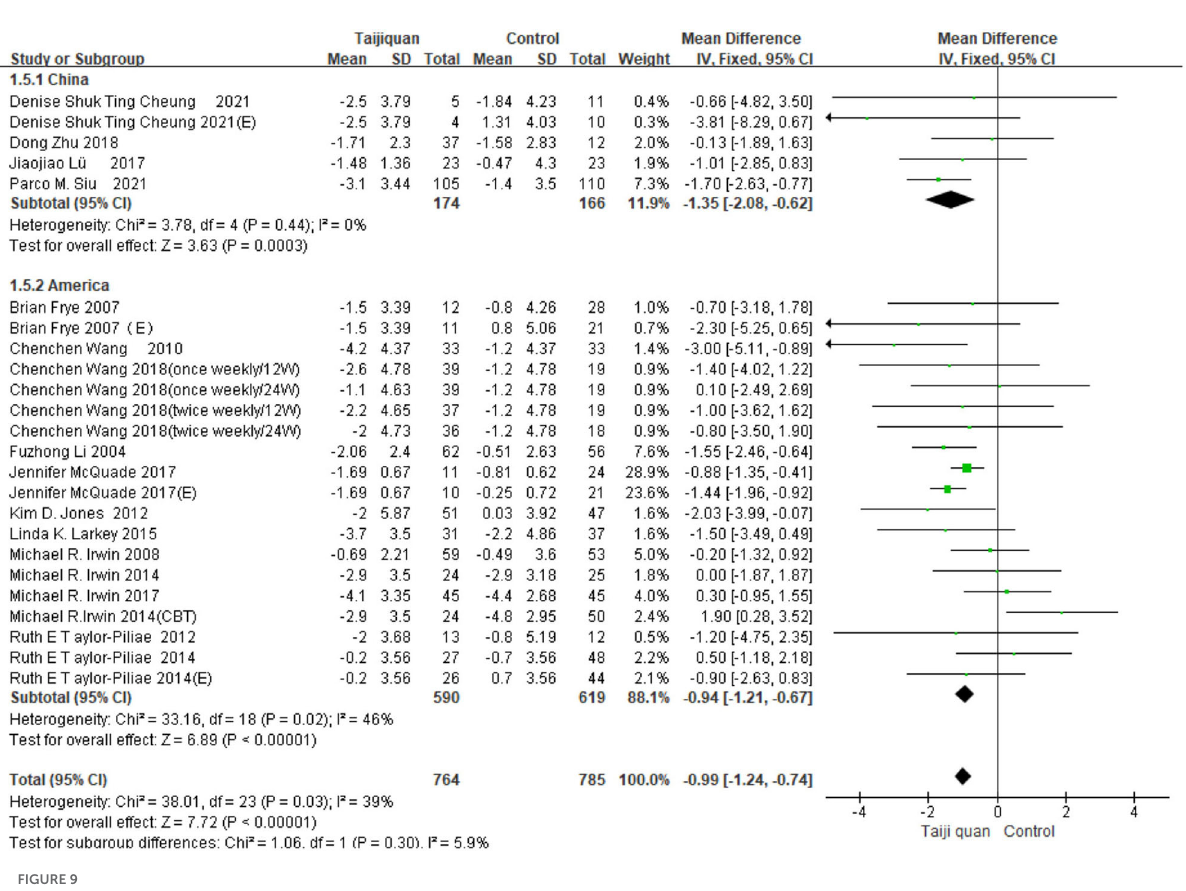
FIGURE9 Subgroups of different countries analyzed forest plot.